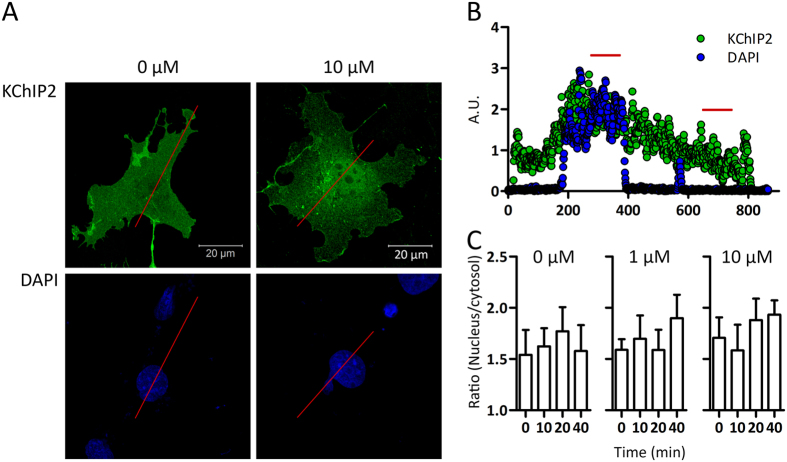
KChIP2 localization in heterologous expression systems.(A) COS-1 cells transfected with KChIP2 and treated with 0 μM and 10 μM ionomycin for 40 min. The extracellular [Ca2+] was 1.8 mM. Pictures showing representative cells stained using a KChIP2 antibody (green). The nucleus is stained blue using DAPI. (B) Graph showing the intensity of the KChIP2 and DAPI signals along the red line in panel A for the cell treated with 10 μM ionomycin. One hundred consecutive values were chosen within both the cytosol and nucleus for quantification of protein localization (indicated by red lines). (C) Quantitative analysis of the time- and concentration-dependency of KChIP2 translocation from the cytosol to the nucleus using ionomycin as a trigger. Five cells from each transfection (n = 4–5) were chosen for quantification and compared using a 1-way ANOVA.